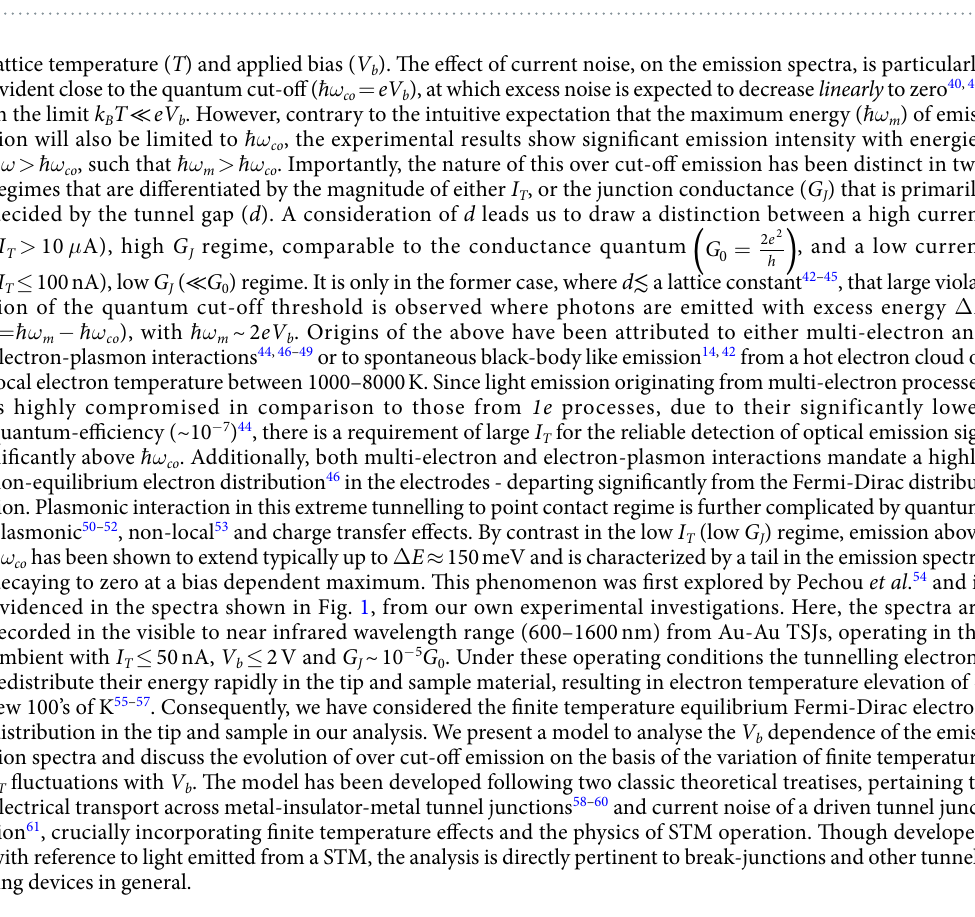
Figure 1. ( a , b ) STM light emission spectra recorded with various applied bias, at constant current (~10 nA). Vertical lines demarcate the energies corresponding to ħ ω co = eV b